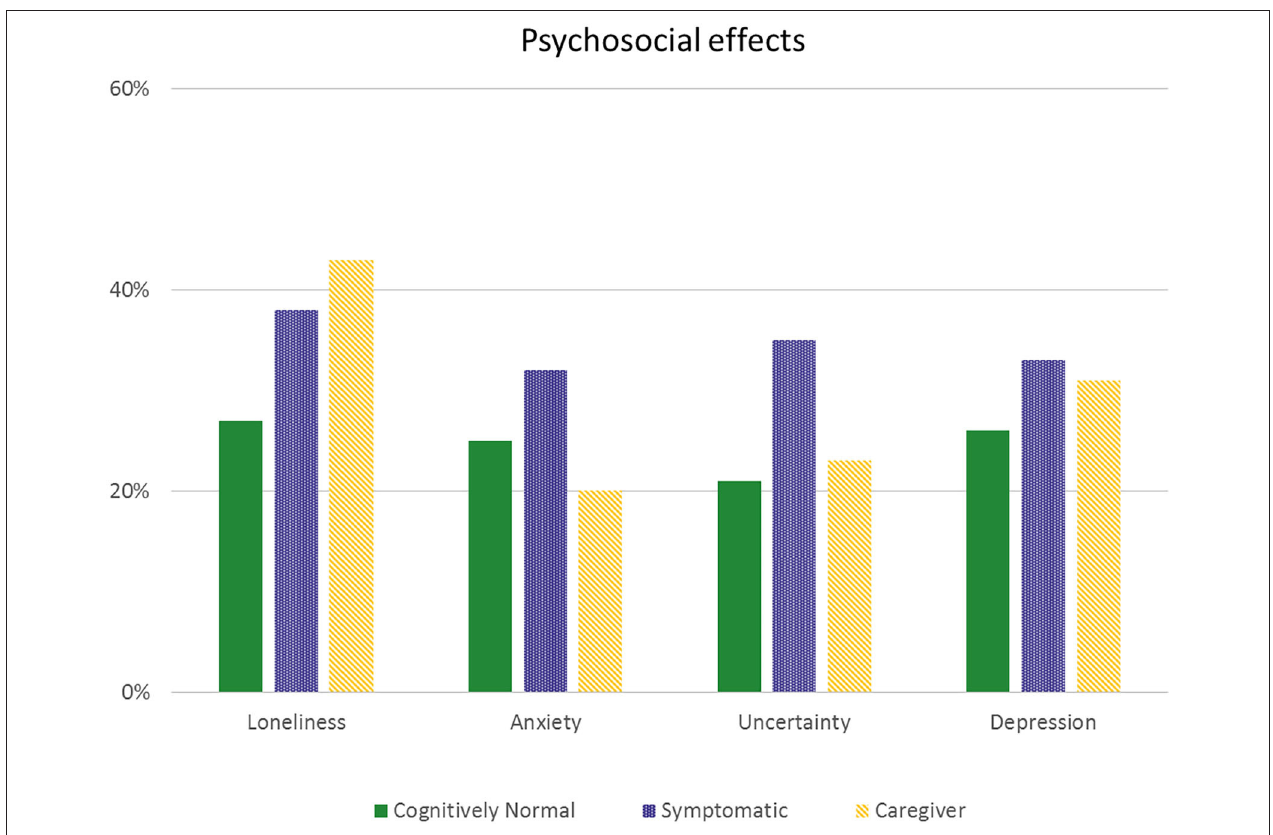
FIGURE 1 | Self-reported psychosocial effects. Self-reported increase in feelings of loneliness, anxiety, uncertainty and depression in patients and